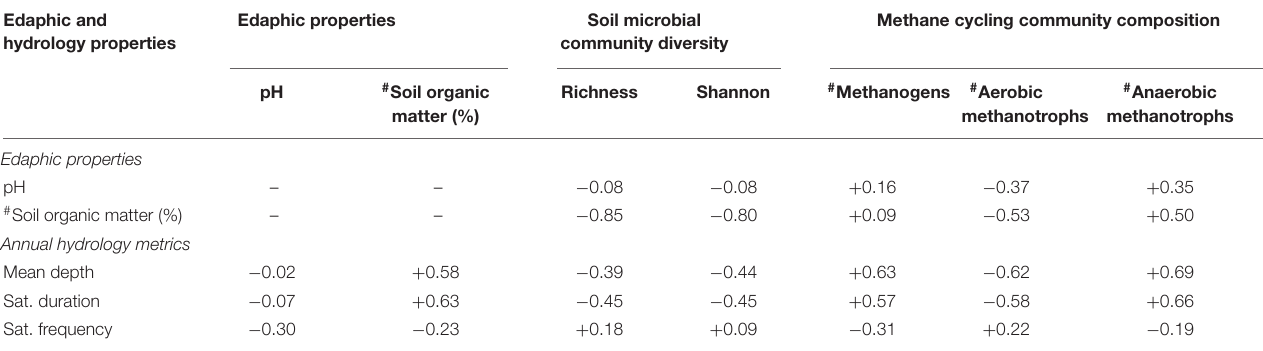
TABLE 3 | Pearson correlation coefficient ( r ) among annual hydrology metrics, soil microbial community diversity measures, and relative abundance (%) of methane cycling microbes. Edaphic and hydrology properties